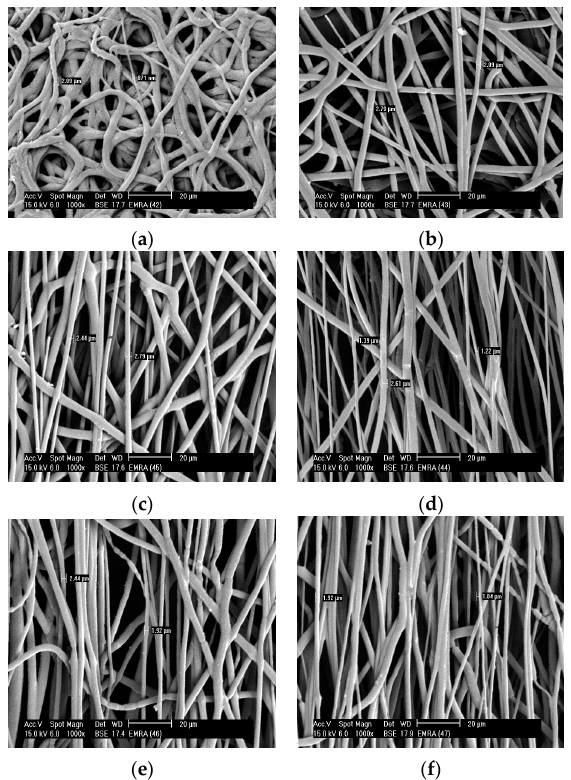
Figure 4. The samples of blend 2 were collected on the aluminum foil with the following polymer concentrations, die diameter, applied voltages, CF/DMF ratios, flow rate, and distance between the needle and target: 25 wt %, 1.3 mm, 20 kV, 90:10, 0.185 µm ⋅ h − 1 , and 20 cm. ( a ) at a fixed target (random); ( b ) at a rotating drum with a speed of 380 rpm; ( c ) at a rotating drum with a speed of 490 rpm; ( d ) at a rotating drum with a speed of 610 rpm; ( e ) at a rotating drum with a speed of 740 rpm, and ( f ) at a rotating drum with speed 850 rpm.